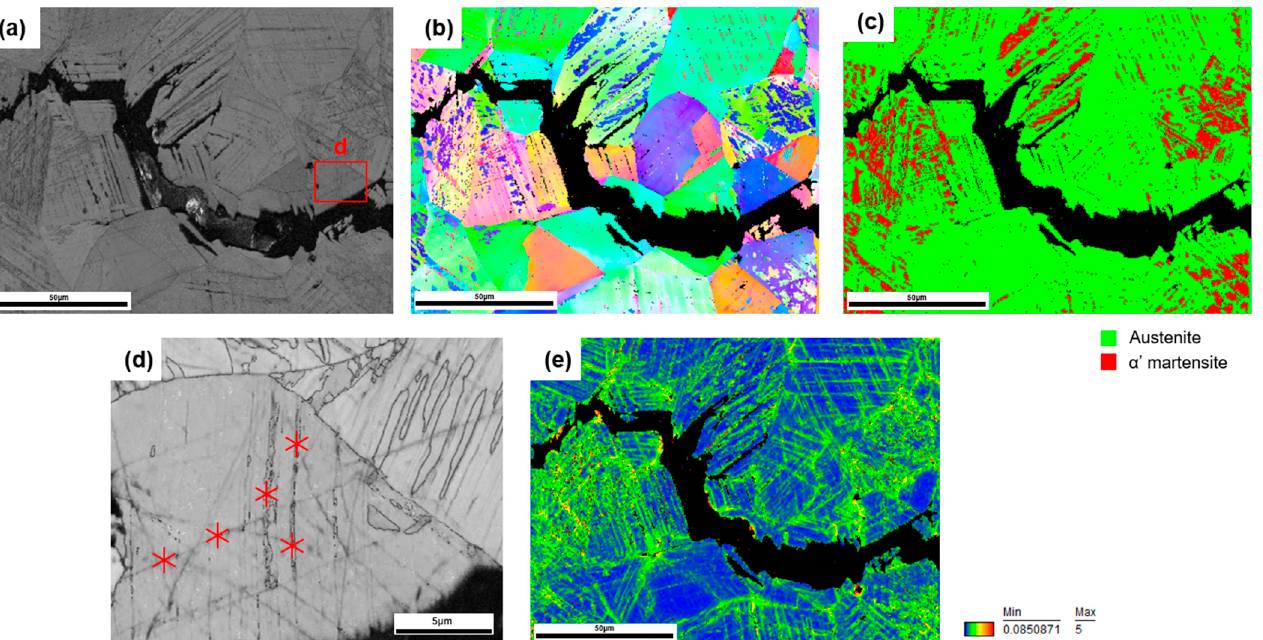
Figure 6. ( a ) Image quality map, ( b ) orientation map, ( c ) phase map obtained from the cracked area based on EBSD and ( d ) enlarged image indicated with red rectangle in ( a ) shows {111} slip traces denoted by the red line. ( e ) KAM map exhibits high local strain at the interface between martensite and austenite and crack tends to propagate along that region.